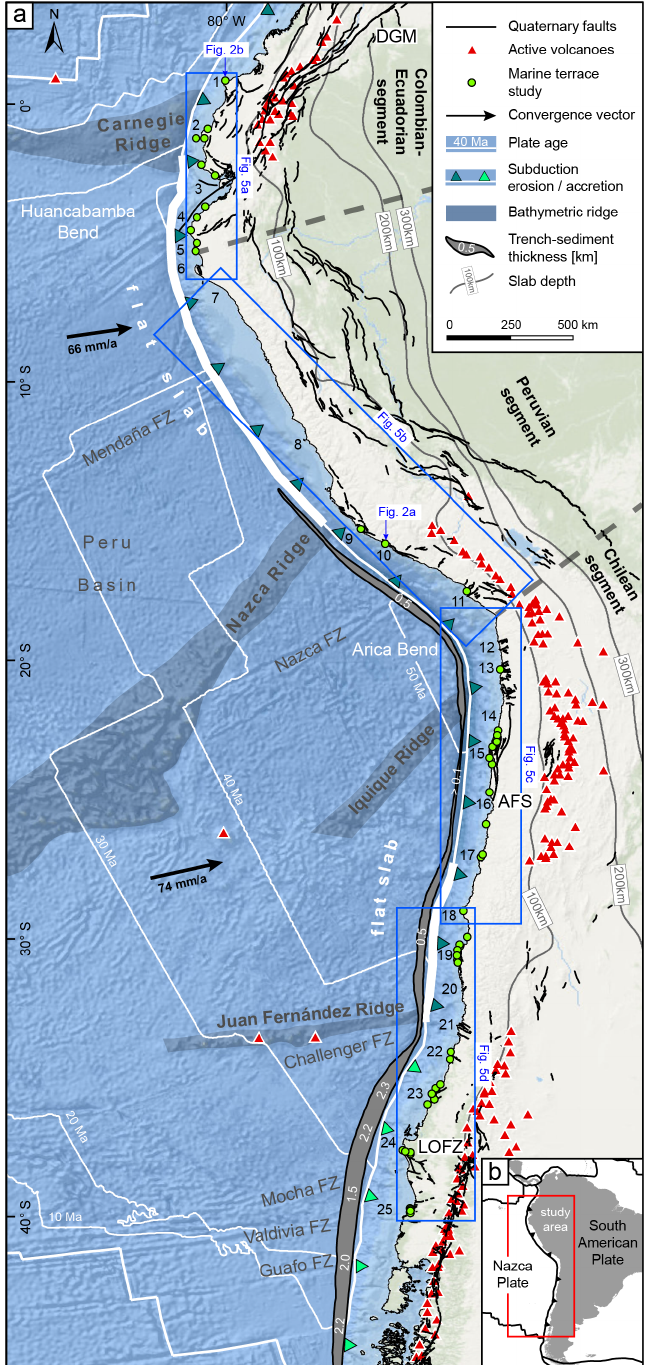
Figure 1. (a) Morphotectonic setting of the South American margin showing major fault systems and crustal faults (Costa et al., 2000; Veloza et al., 2012; Maldonado et al., 2021), slab depth (Hayes et al., 2018), flat-slab subduction segments, active volcanos (Venzke, 2013), bathymetric features of the subducting plate, trench-sediment thickness (Bangs and Cande, 1997), segments of subduction erosion and accretion (Clift and Vannucchi, 2004), plate age (Müller et al., 2008), convergence vectors (DeMets et al., 2010), and marine terrace ages used for lateral correlation. DGM: Dolores–Guayaquil megashear; AFS: Atacama fault system; LOFZ: Liquiñe–Ofqui fault zone; FZ: fracture zone; 1: Punta Galera; 2: Manta Pen.; 3: Gulf of Guayaquil, Santa Elena Pen.; 4: Tablazo Lobitos; 5: Paita Pen.; 6: Illescas Pen.; 7: